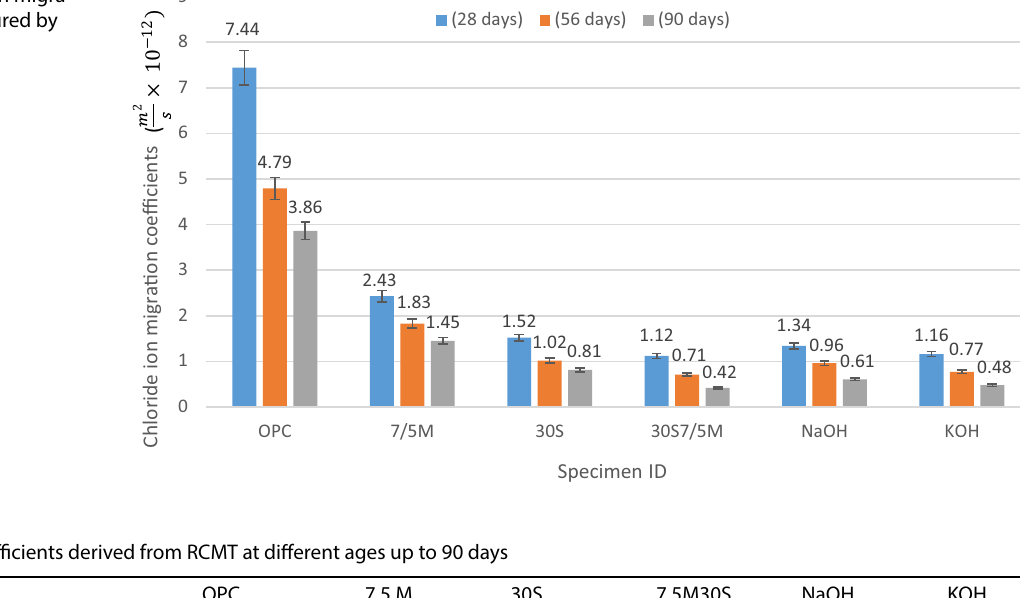
Normalized migration Coe. 28